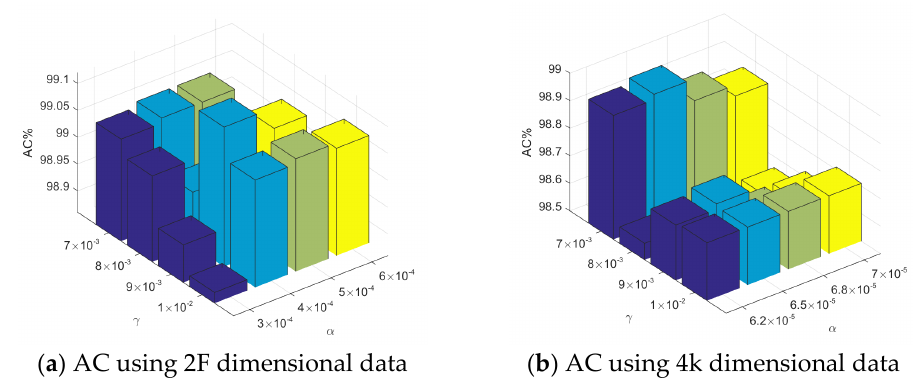
Figure 4. The AC values when using the Hopkins 155 dataset with 2F- and 4k-dimensional data. (cid:8) (cid:9) parameter settings. We set λ = 0.07, α = 7 × 10 − 2 , 8 × 10 − 2 , 9 × 10 − 2 , 1 × 10 − 1 and γ = { 1.61, 1.64, 1.67, 1.70 } . To observe the changes in the AC and NMI values that were caused by the BDLSR-Z method, we took 40 individuals from the ORL dataset as the example. From Figure 5, it can be seen that the AC values changed significantly and the NMI values changed slightly within a certain value range. When α = 9 × 10 − 2 and γ = 1.67, BDLSR-Z produced the best clustering effect.